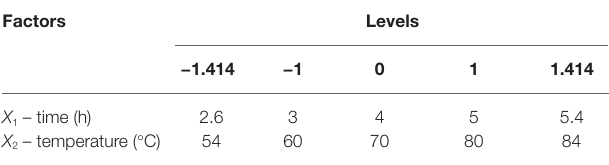
TABLE 3 | Range and levels of variables for CCD. Factors